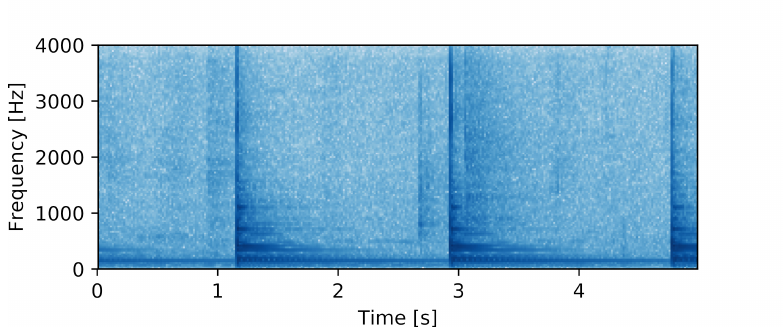
Figure 8. Spectrogram view of a tie-rod recording. The spectrogram view shows frequency content over time, highlighting the portions of the recording corresponding to the